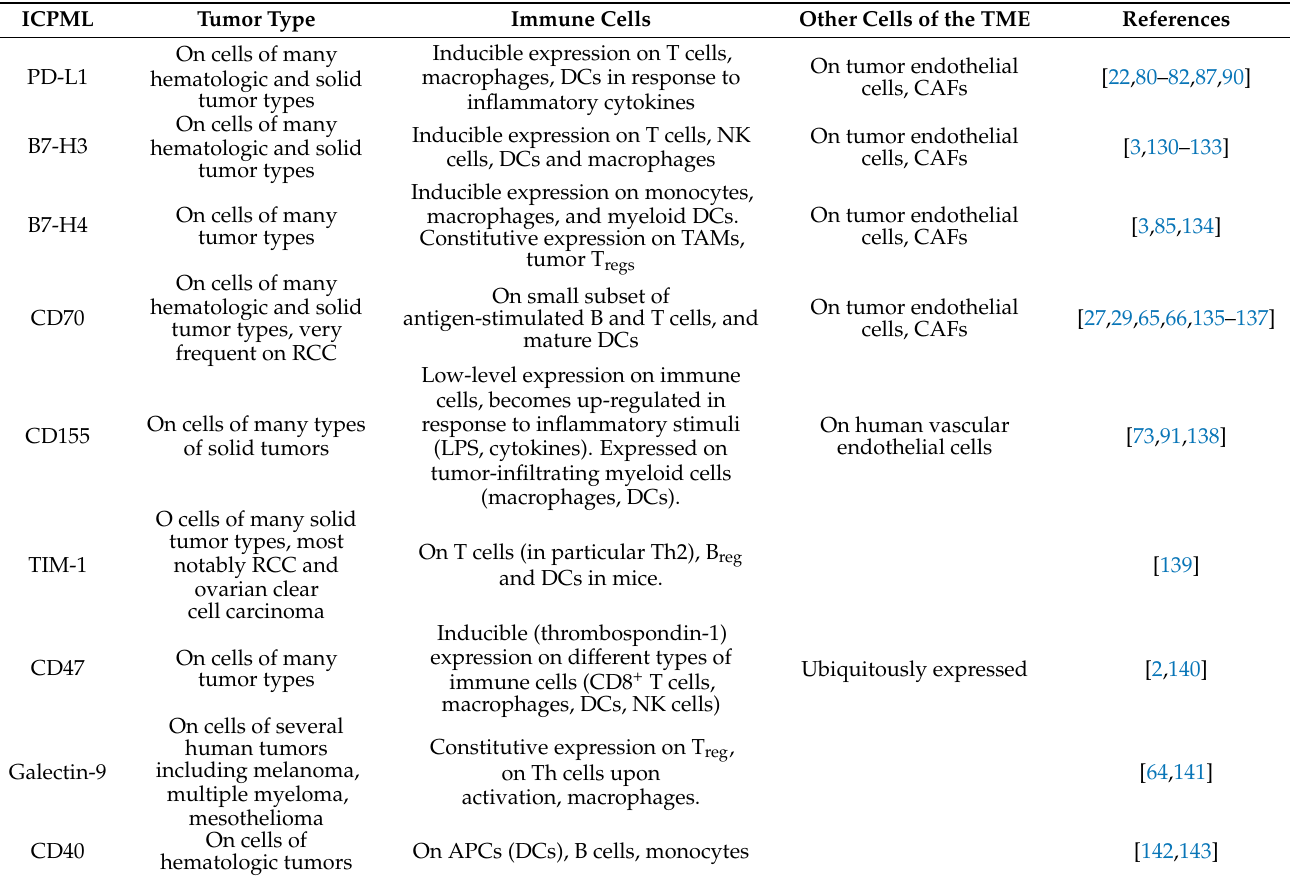
Table 1. Expression of ICPMLs on tumor cells, immune cells and other cells of the tumor microenvironment (TME).